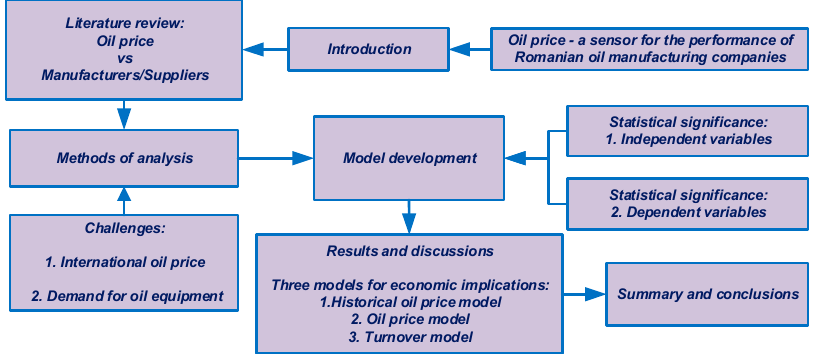
Figure 1. Graphic abstract of the article (source: authors based on article content).